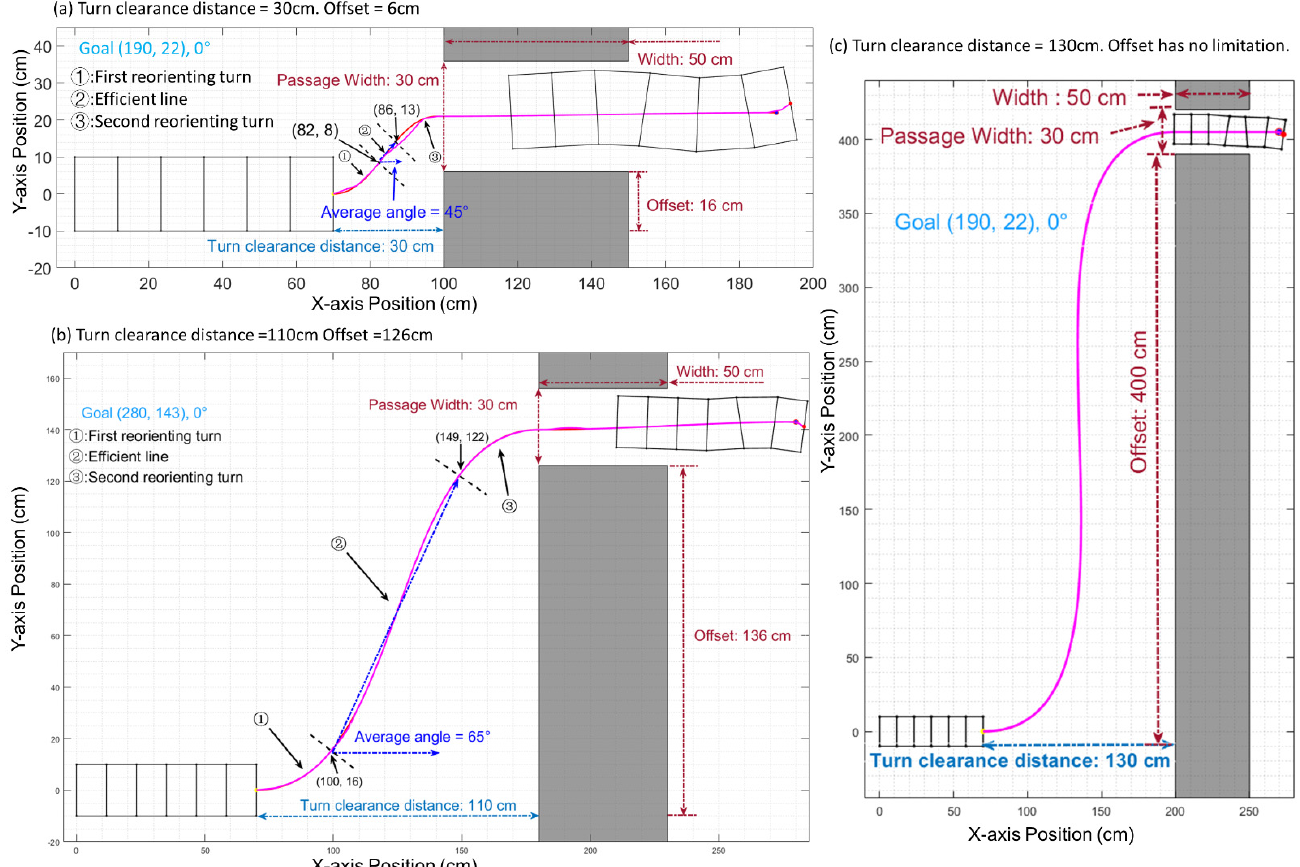
Figure 8. As the robot moves farther from the obstacle, the maximal passable offset dramatically increases. In case ( a ), the distance is 30 cm, and the robot can overcome an obstacle with a 16 cm offset. In case ( b ), the distance becomes 110 cm; the robot can overcome a 136 cm offset obstacle. In case ( c ), the distance is 130 cm; the robot can overcome any obstacle of any offset (400 cm offset shown as example).